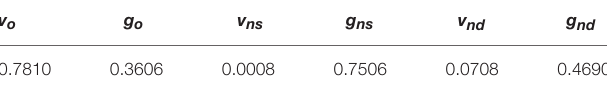
TABLE 6 | EOD-disjunction paradigm: Optimized fit of Hamiltonian parameters under β > 0 (RMSE 0.0073), and β < 0 (RMSE =